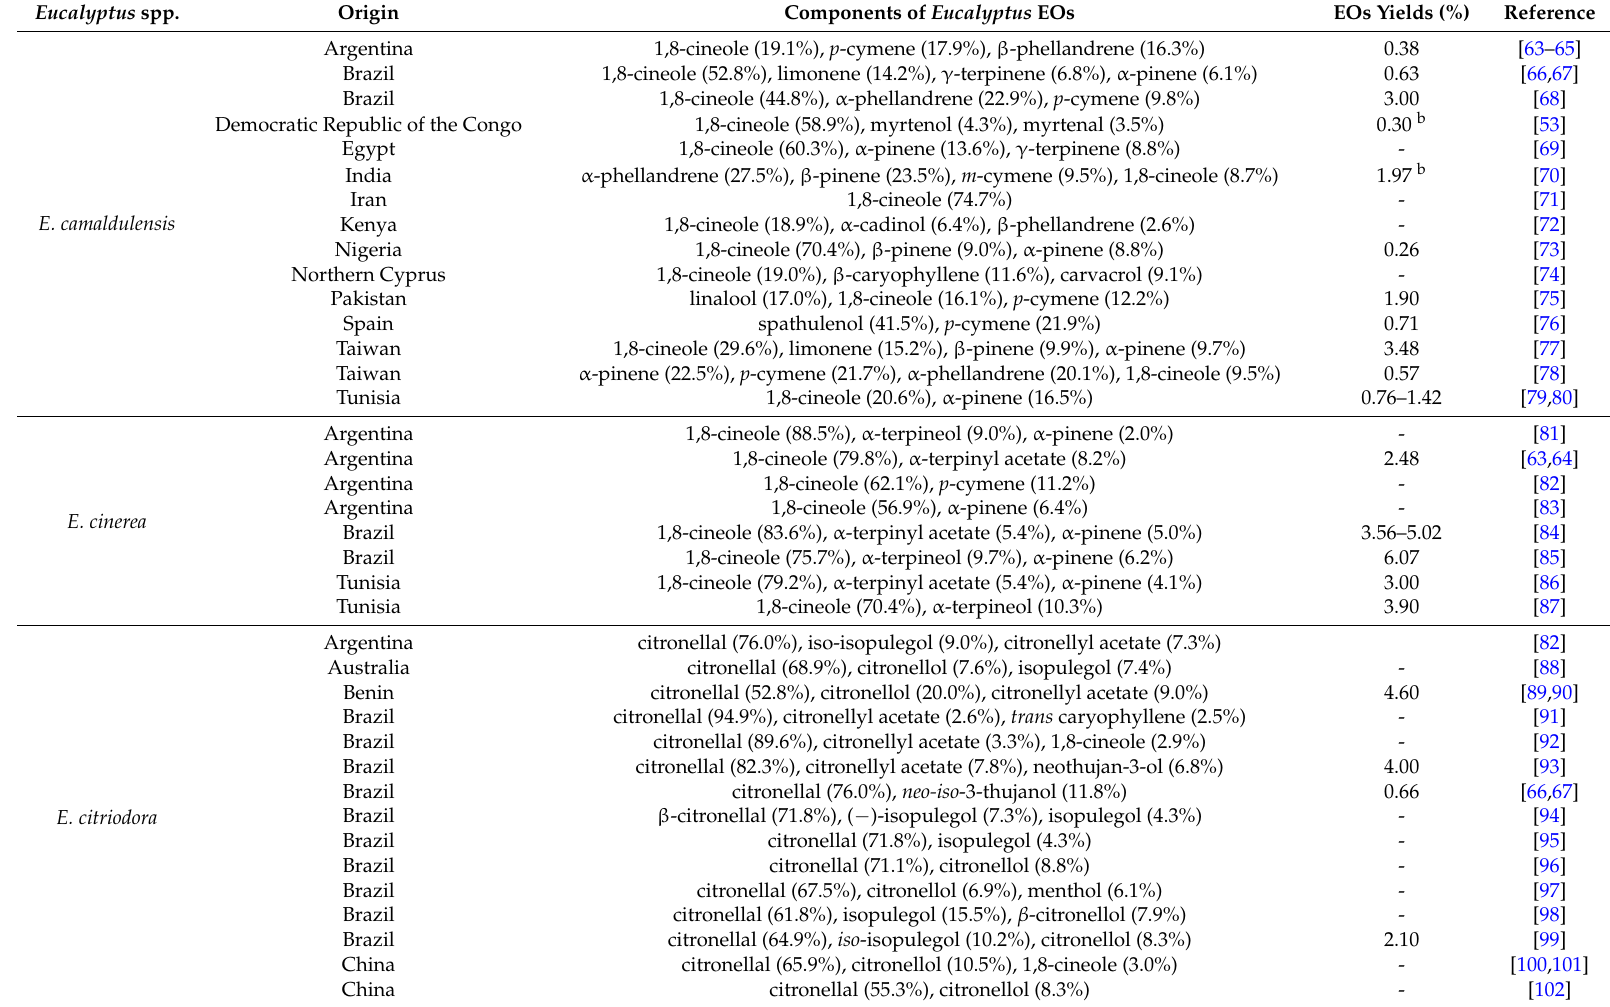
Table 1. Some common chemical components of essential oils extracted from leaves of Eucalyptus spp. a . Eucalyptus